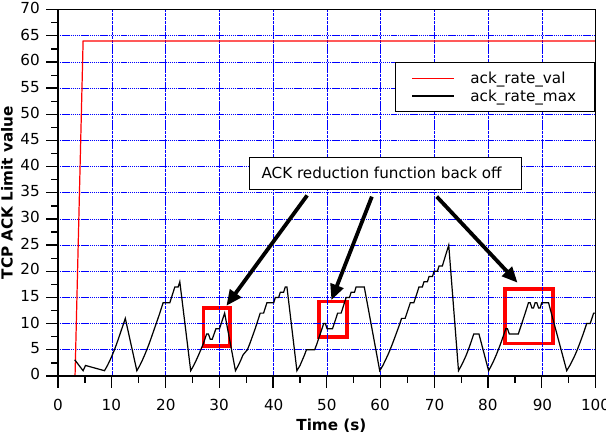
Figure 10. The change of ack_rate_max and ack_rate_val during TCP session. It can be seen that ack_rate_val starts to increase after approximately 10 s of the beginning of the TCP session, its value changes from zero and reaches its maximum at approximately 20–25 s. At approximately 30 s, the algorithm notices a degradation of TCP throughput and the first decrease off ack_rate_val is observed, which indicates that ACK rate limiting is functioning. At the same time, the decrease of ack_rate_val is again observed at approximately 50 s and 80 s, which indicates that the TCP packets transmission rate has been reduced. Additionally, TCP data and ACK rates have been monitored with wireshark to analyze the impact of the ACK limiting algorithm on overall TCP session